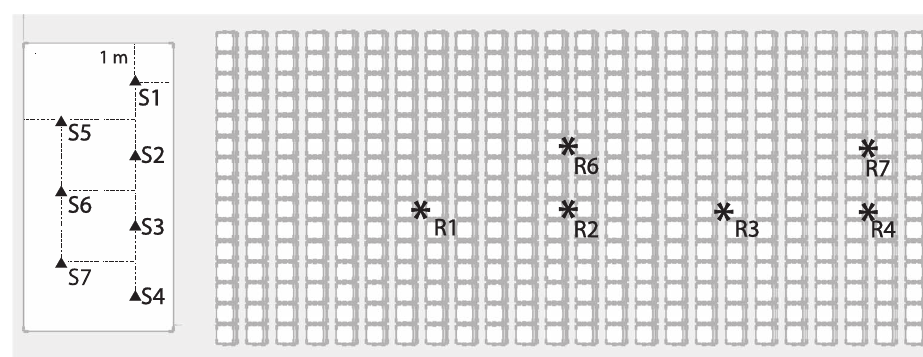
Figure 2. The source-receiver locations of the scale model. The line segment on stage is 1 m.